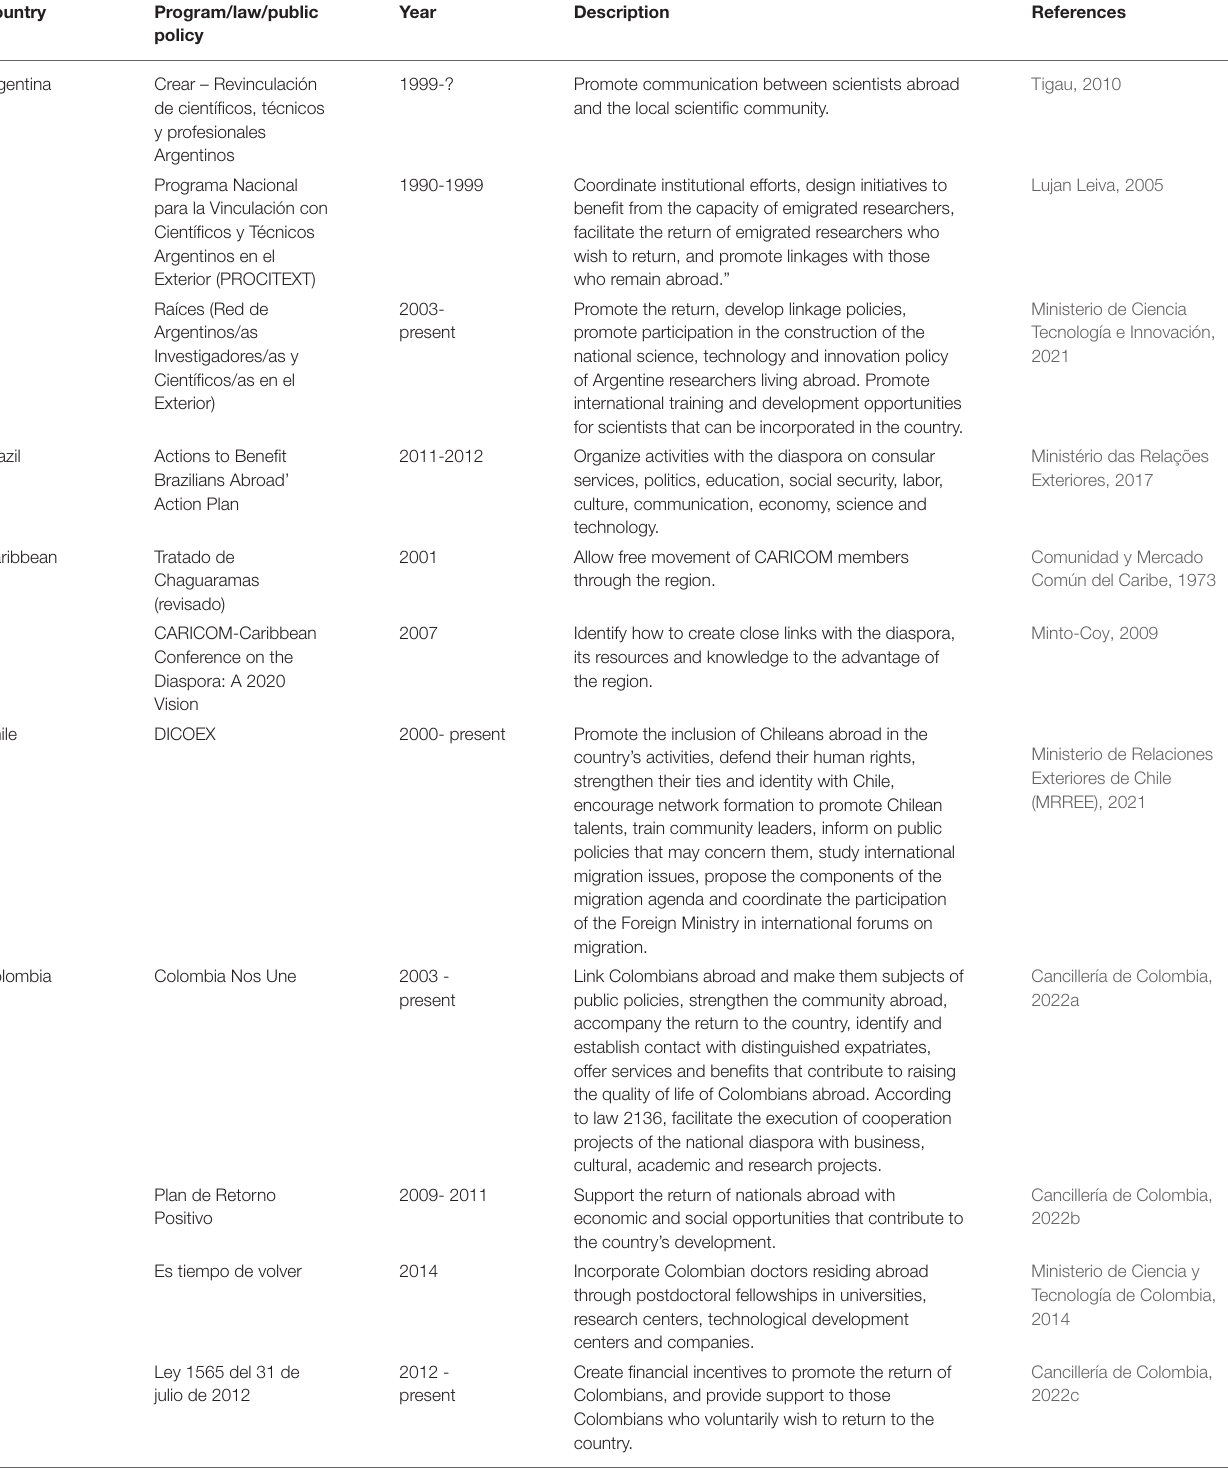
TABLE 1 | Examples of programs, laws or public policies regarding the highly qualified diaspora in Latin America and the Caribbean from 1990 to 2021.